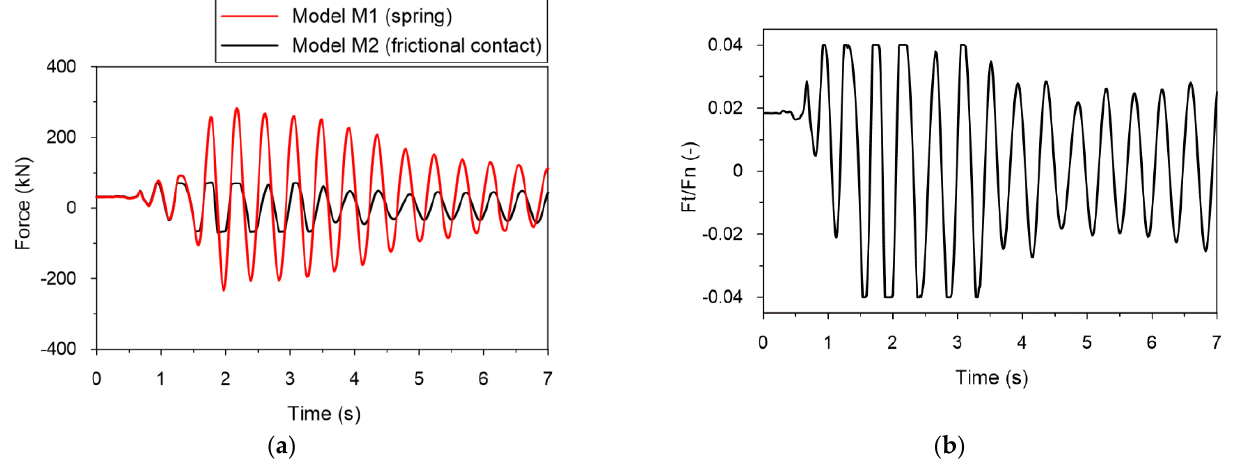
Figure 21. Comparison of: ( a ) the forces generated in the connector (models M1 and M2); ( b ) the friction force to the normal contact force ratio (model M2), obtained for the tremor of medium intensity (D_II).